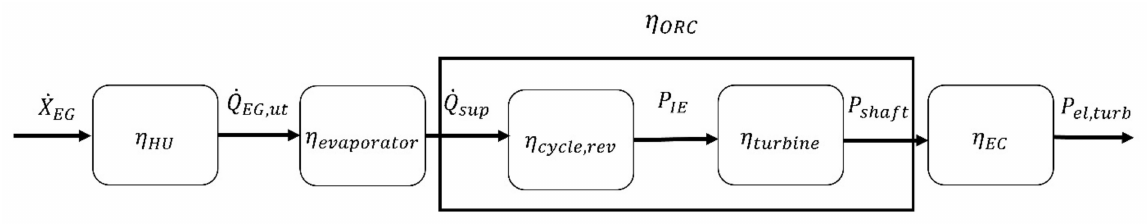
Figure 3. Energy conversion chain of the